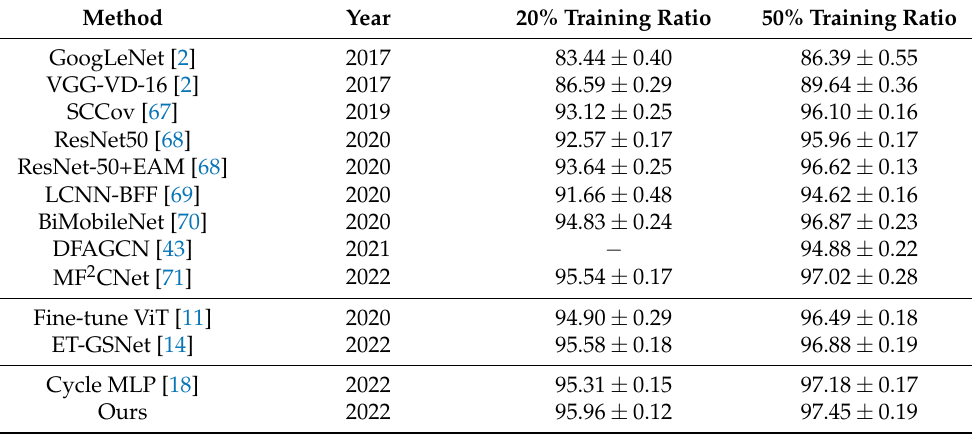
Table 3. The comparison of OA on the AID Dataset.